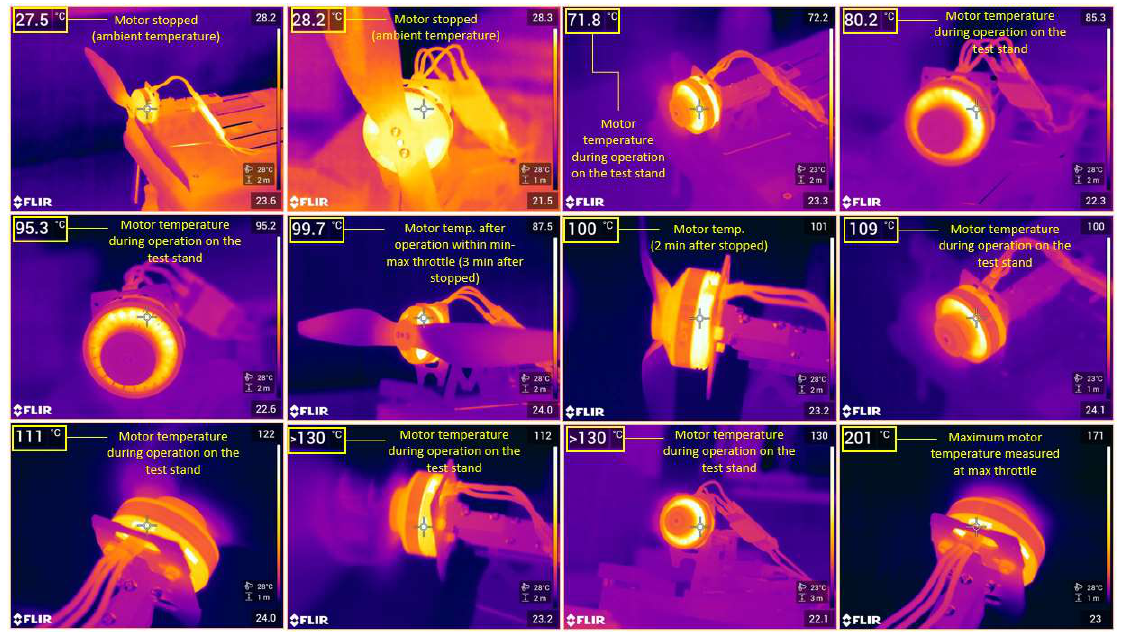
Figure 15. Measurement of motor temperature during operation on the test stand, within 5–100% throttle range.